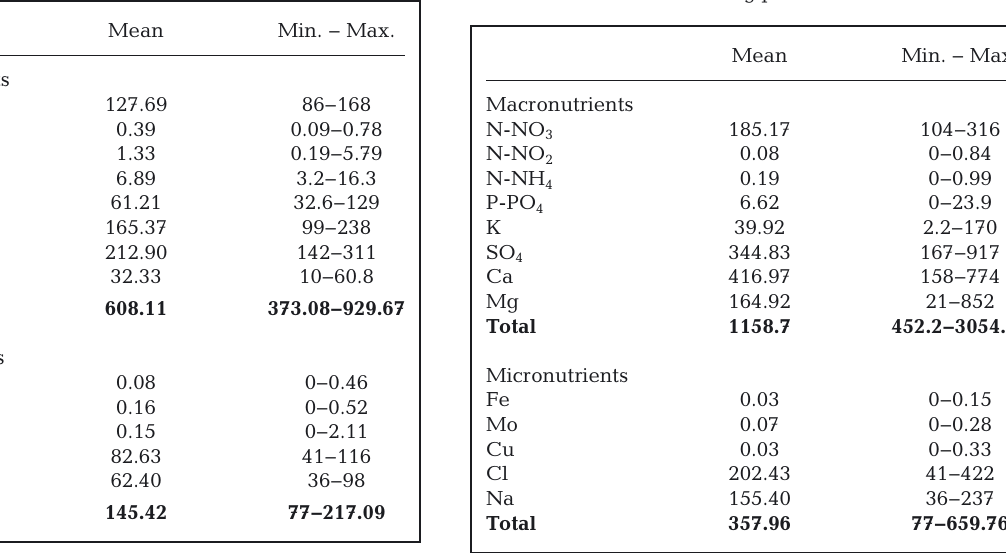
Table 1. Mean, minimum, and maximum concentrations (mg l −1 ) of macro- and micronutrients in the aquaculture recirculation system during the course of the testing period